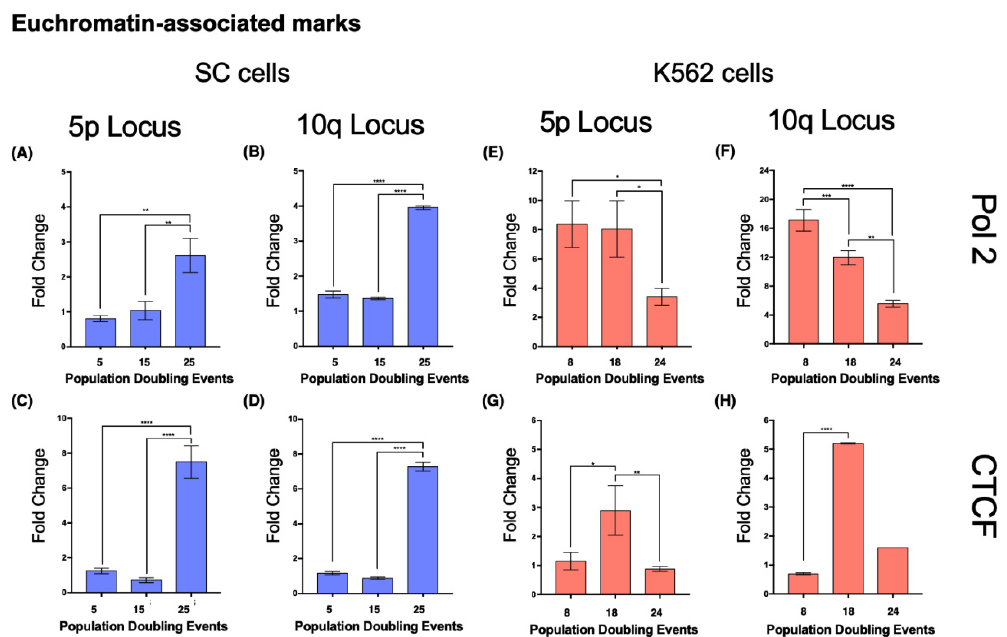
Figure 10. Euchromatin-associated proteins accumulated on both analyzed loci in the SC cell line. Chromatin immunoprecipitation was carried out to analyze the abundance of the euchromatin-associated proteins’ RNA Polymerase 2 (Pol 2) and the CCCTC binding factor (CTCF). Note the different scales on the axes of the graphs. ( A – D ) As the culture aged, both proteins accumulated in loci 5p and 10q of the SC cells. ( E , F ) The levels of Pol 2 diminished at loci 5p and 10q as the K562 cells aged. The reduced levels of Pol 2 that were found after 24 PDs in K562 cells were close to the levels accumulated on the same loci of the SC cells after 25 PDs. ( G , H ) The levels of CTCF increased on both loci after 18 PDs of the K562 cells, but after 24 PDs, they returned to their original values. Data were analyzed using ANOVA and Tukey’s multiple comparisons test. Adjusted p value < 0.0001 (****), = 0.0008 (***), < 0.01 (**), < 0.05